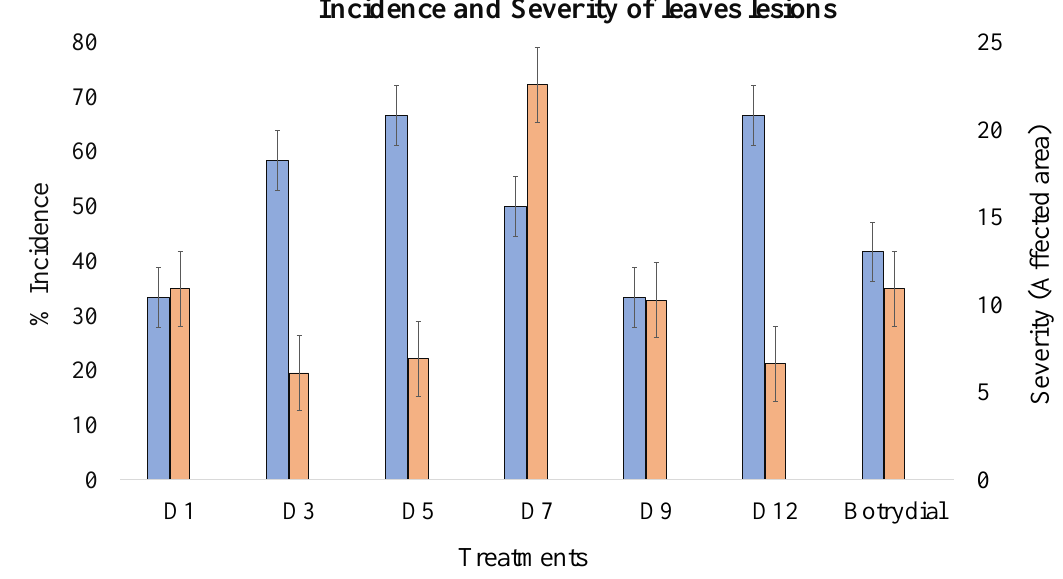
Figure 10. Incidence (blue bars, left Y-axis) and severity (orange bars, right Y-axis) of lesions in Solanum lycopersicum leaves caused by B. cinerea extracts.